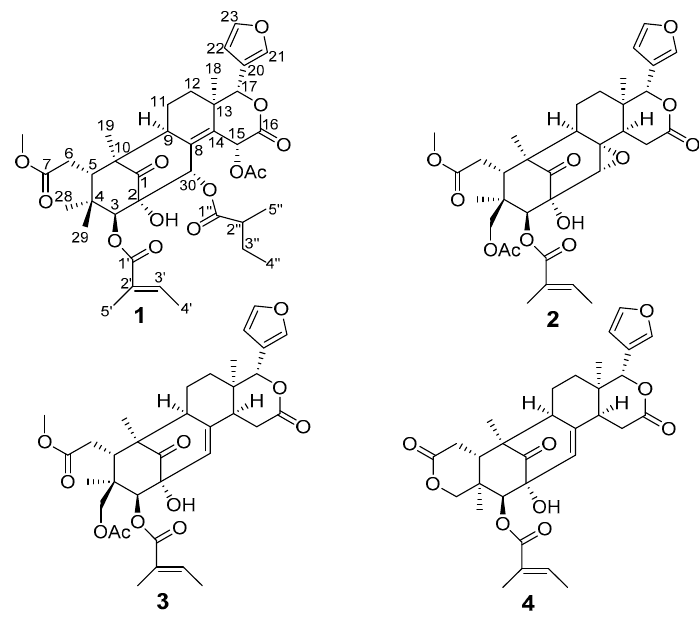
Figure 1. Structures of trichinenlides U–X ( 1 – 4 ).